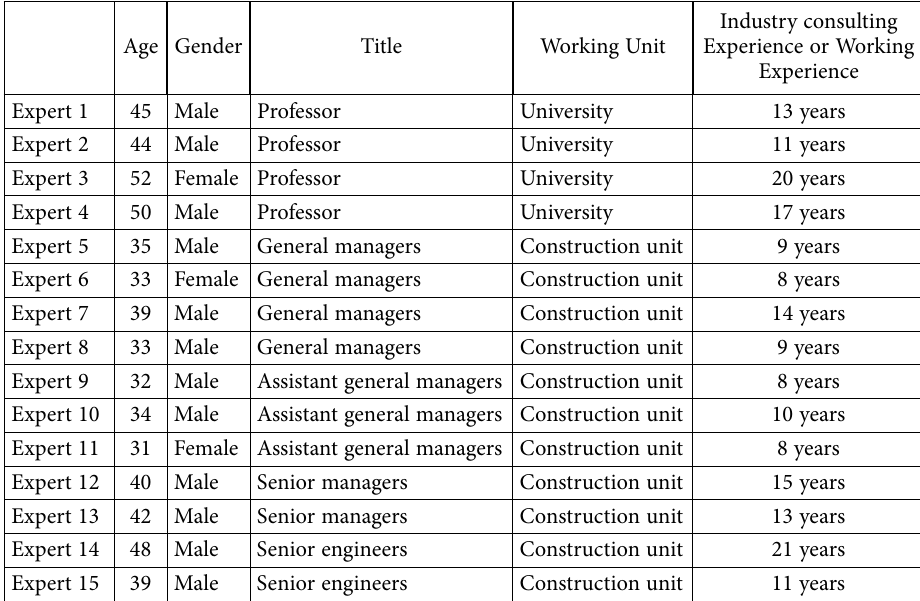
Table 3. The experts’